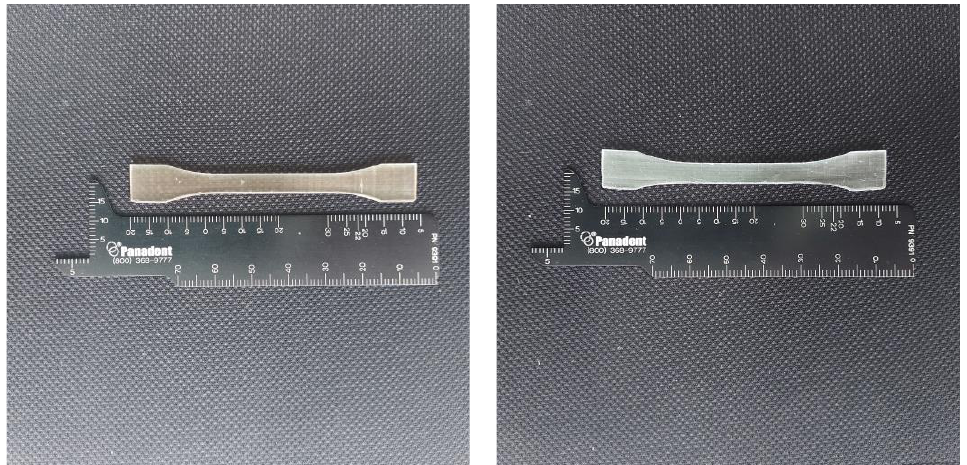
Figure 2. The dumbbell shape of the samples used for the tensile test, the sample size according to the ISO 527-2:2012 norm: length 75 mm, end width 10 mm, thickness 2 mm ( left — BioMed Amber, right — Dental Clear LT).